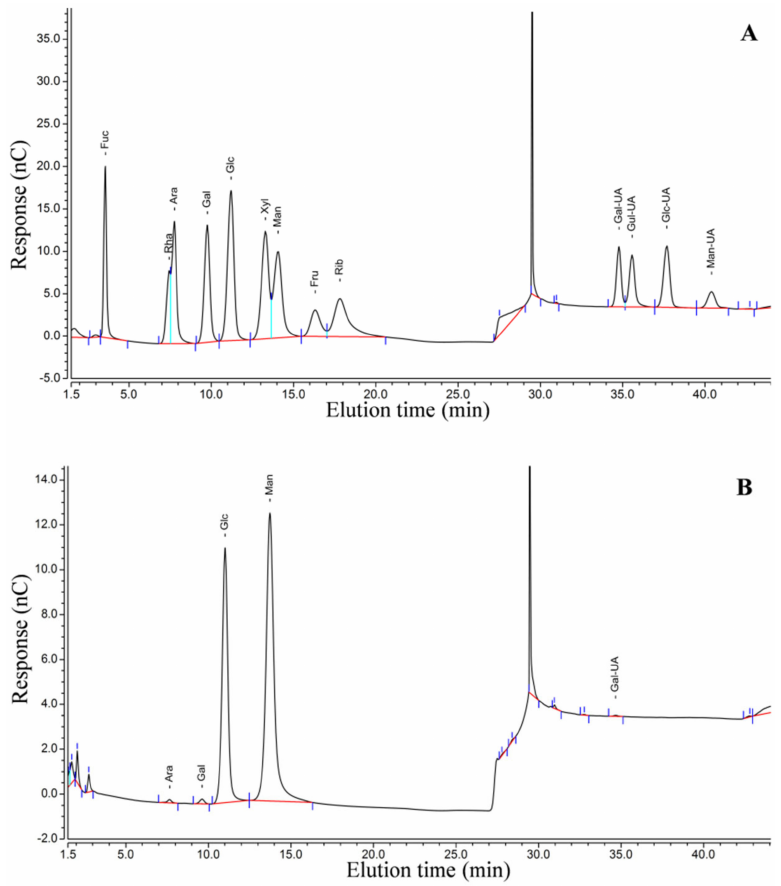
Figure 5. Ion chromatographic profile of monosaccharide standards ( A ) and the processed DhPs ( B ). Peaks: Ara (Rt: 7.76 min); Gal (Rt: 9.77 min); Glc (Rt: 11.22 min); Man (Rt: 14.08 min); Gal-UA (Rt: 34.87 min). Note that the chromatographic peak at ca 30 min represents sodium acetate (NaAc). From the FT-IR spectrum of processed DhPs (Figure 6), three typical absorption peaks of polysaccharides were detected. The first was a wide and strong stretching peak at 3423.99 cm − 1 indicating the O-H stretching vibration. The second and the third were the weak absorption peaks at 2931.50 cm − 1 and 2891.14 cm − 1 , respectively, for the C-H (-CH 3 and -CH 2 ) stretching vibration. Peaks ranging from 1450 to 1200 cm − 1 (1420.82 cm − 1 , 1378.38 cm − 1 and 1250.50 cm − 1 ) indicated C-H deviational vibration. Peaks at 1066.11 cm −